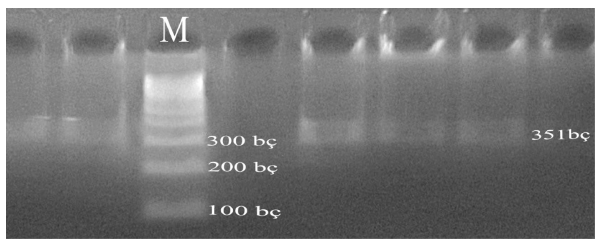
Figure 1. Agarose gel view of PCR products (M stands for marker; CSN3 is 351bp).